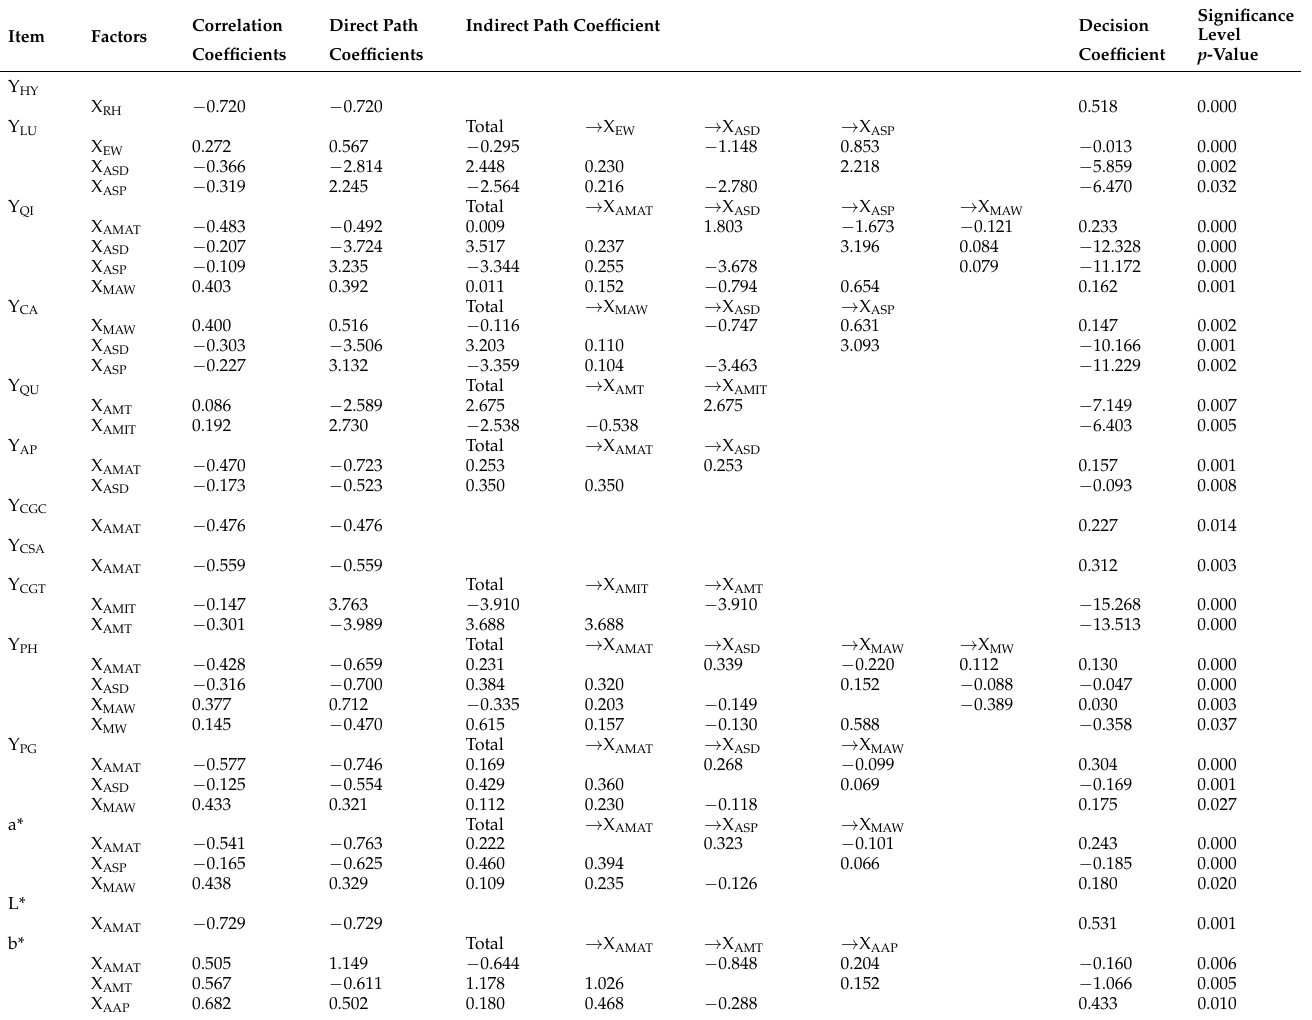
Table 3. Path analysis between climate factors and flavonoids of Chinese prickly ash